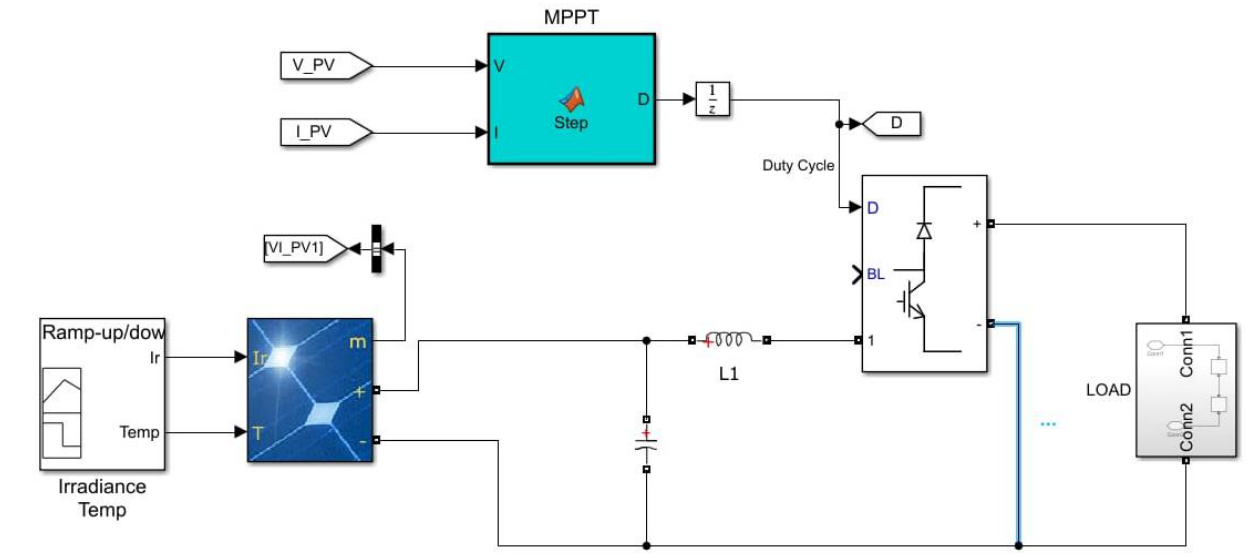
Fig. 4. Standalone solar photovoltaic